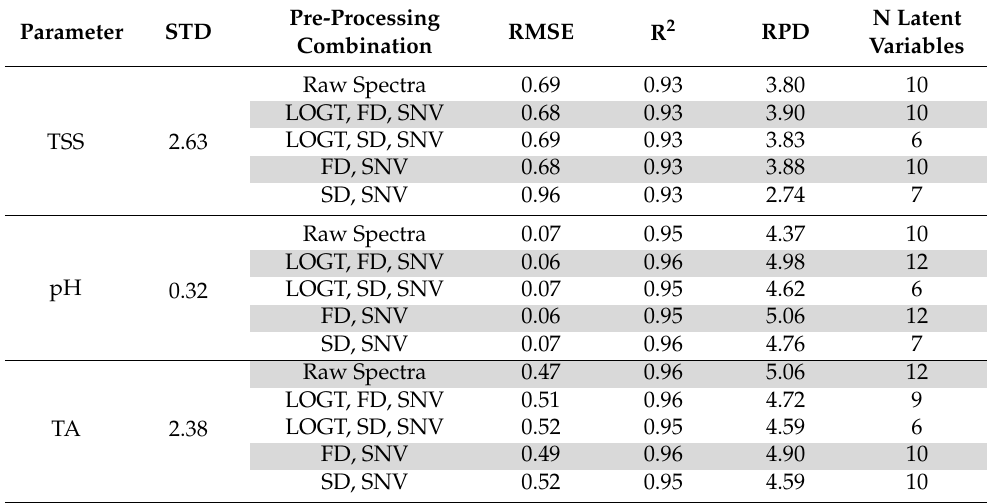
N Latent Variables